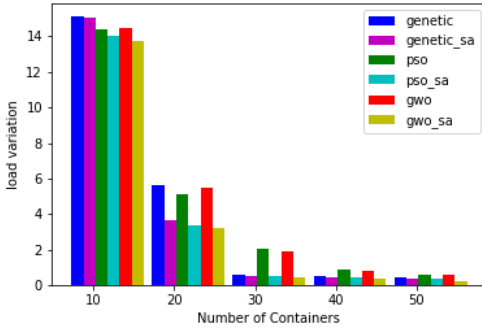
Figure 12. Load variation with 3000